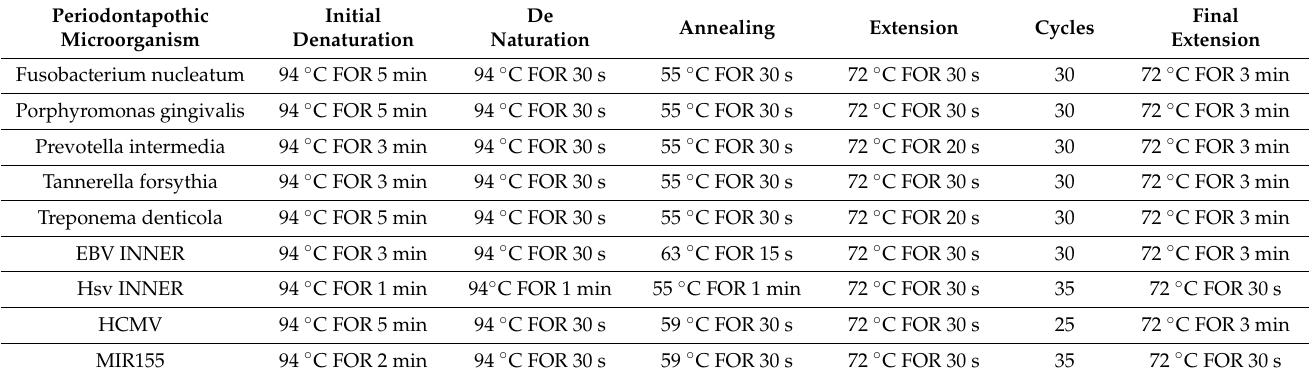
Table 2. PCR conditions and reaction set up for Bacteria and Viruses.